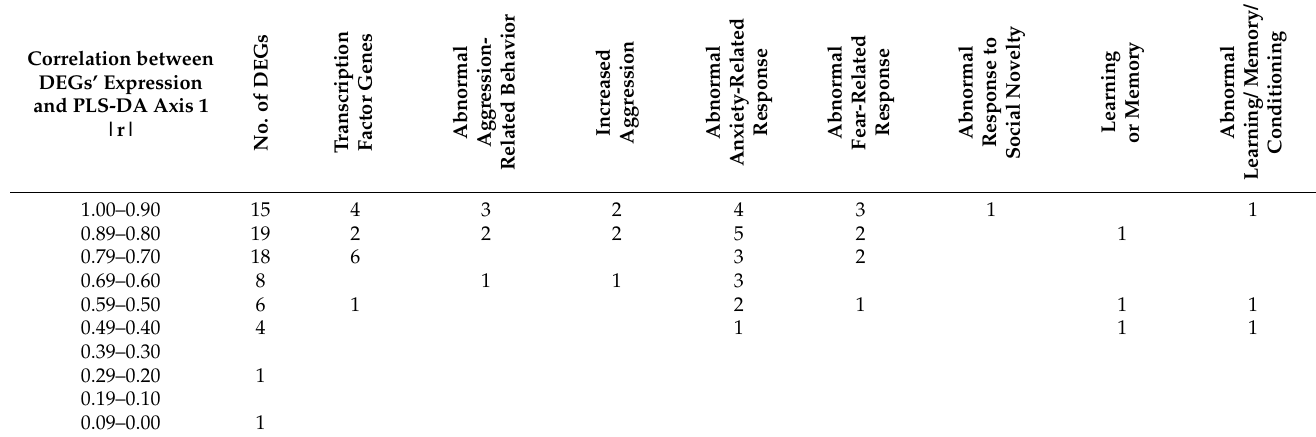
Table 1. Characterization of C_A20 DEGs associated with neurogenesis.